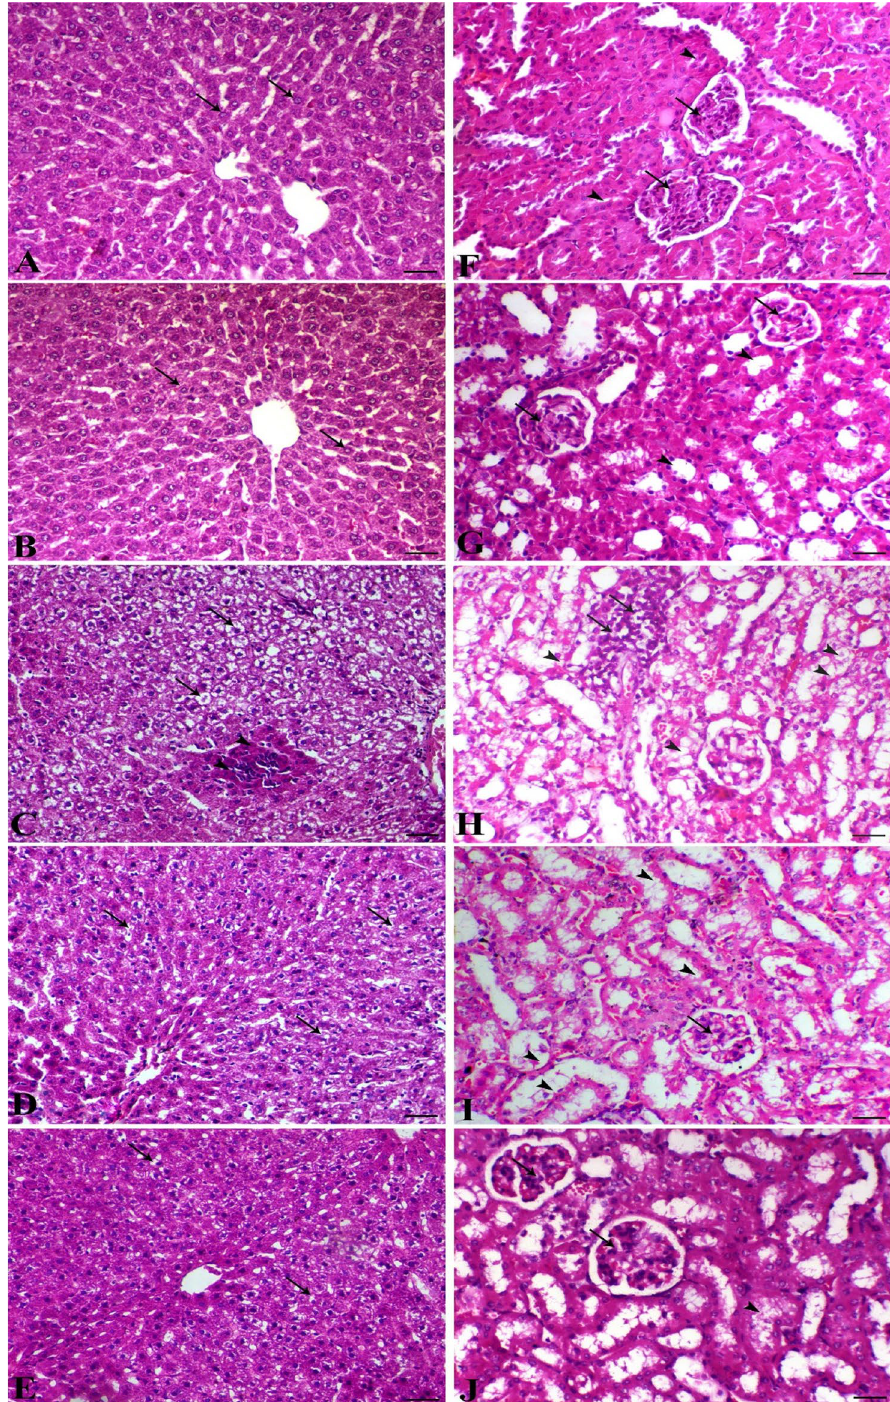
Figure 3. Hepatic (A–E) and renal sections (F–J) of different treated groups. (A) Liver of control group (arrows indicate normal hepatocytes); (B) liver of thymoquinone group (arrows indicate normal hepatocytes); (C) liver of malathion group (arrows indicate severe hepatic vacuolation and arrowheads indicate focal area of coagulative necrosis); (D) liver of malathion + thymoquinone (25 mg/kg) (arrows indicate marked decrease of hepatic vacuolation); (E) liver of malathion + thymoquinone (50 mg/kg) (arrows indicate marked decrease of hepatic vacuolation), H&E, bar = 50 µm. (F) Kidney of control group (arrows indicate normal glomeruli and arrowheads show normal renal tubules); (G) kidney of thymoquinone group (arrows indicate normal glomeruli and arrowheads show normal renal tubules); (H) kidney of malathion group (arrows indicate focal interstitial lymphocytic infiltration and arrowheads indicate marked renal tubular epithelium vacuolation); (I) kidney of malathion + thymoquinone 25 mg/kg (arrows indicate marked decrease of renal degeneration); (J) kidney of malathion + thymoquinone (50 mg/kg) (arrowheads indicate marked decrease of renal tubular epithelium vacuolation and arrow shows normal glomerulus), H&E, bar = 50